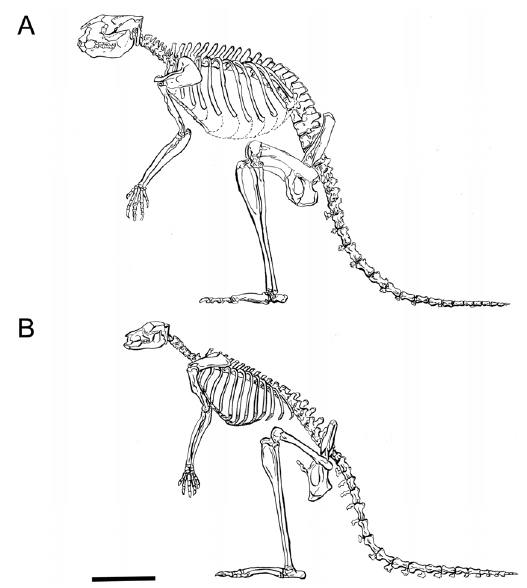
Figure 2. Skeletons of (A) Sthenurusstirlingi and (B) Macropus giganteus . Modified from Wells and Tedford, 1995. Original artist Lorraine Meeker, American Museum of Natural History (reproduced here by